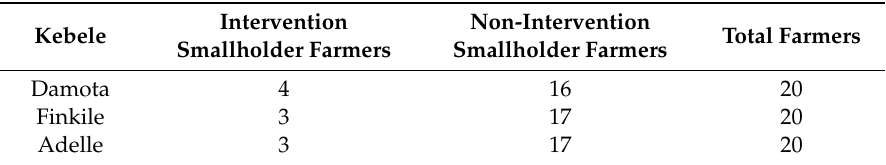
Table 2. Distribution of smallhold farmer’s respondents.